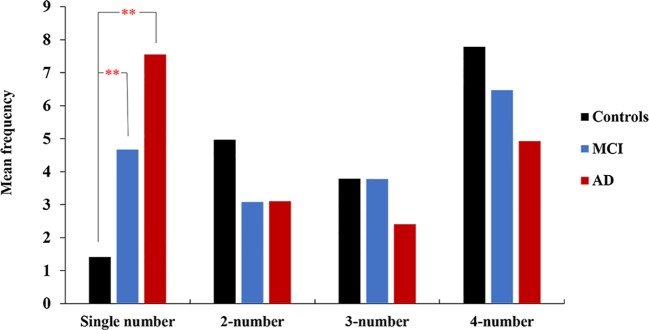
The AD and MCI patients selected one number most frequently, and the controls were more likely to select four-number combinations. Single comparisons between groups revealed significant differences in the frequency of choosing one single number but not two numbers, three numbers and four numbers. **p < 0.01.